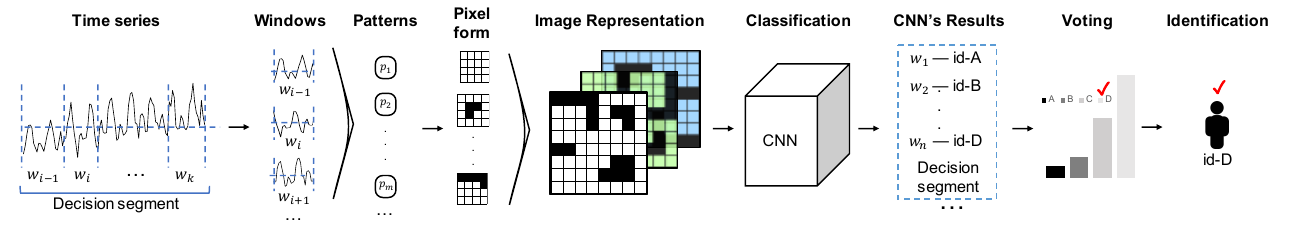
Figure 1. Pipeline of our